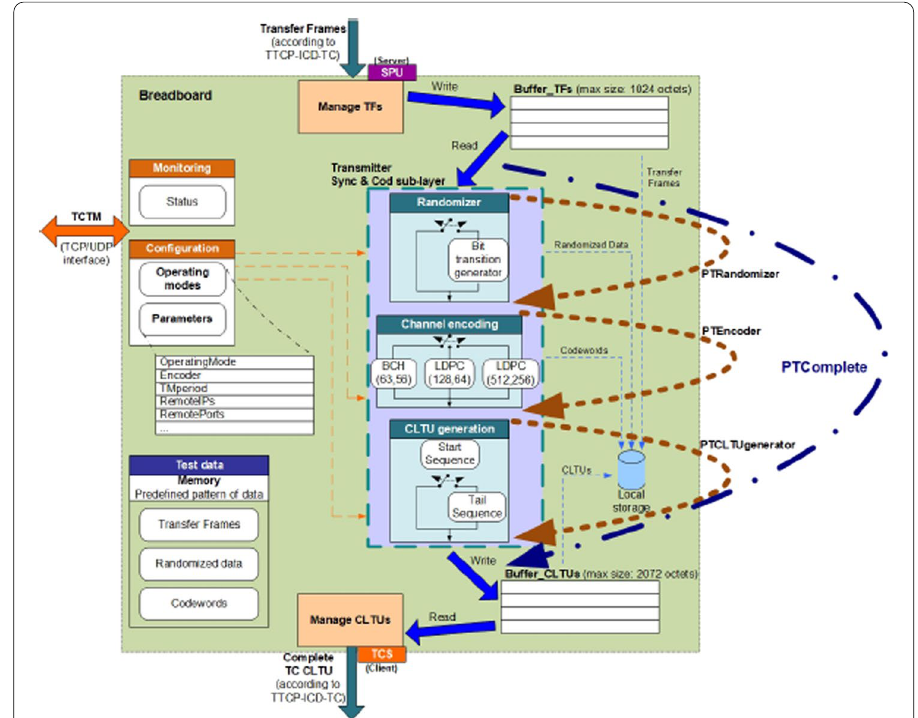
Fig. 15 Schematic of the breadboard architecture and measurement of the processing times for the Breadboard Performance